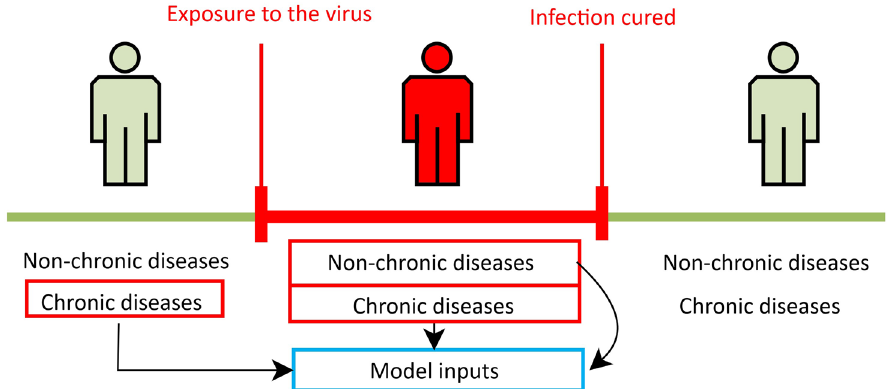
Figure 1. Selection window of the comorbidities. The red window is the period comprised between the beginning of the infection and when the seroconversion occurs.